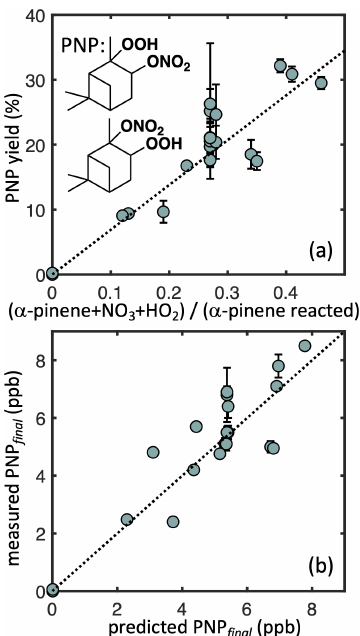
Figure 6. Measured α -pinene nitrooxy-hydroperoxide (PNP) yields as a function of the modeled contribution of the n RO 2 + HO 2 path- way (a) and measured PNP at the end of each experiment as a func- tion of the predicted PNP based on the simple kinetic model. Dot- ted lines denote error-weighted ordinary least squares fits with in- tercepts constrained to zero ( R 2 = 0.88 a , 0.74 b ; slope = 0.58 a , 1.0 b ). Error bars denote uncertainty from CIMS measurements.